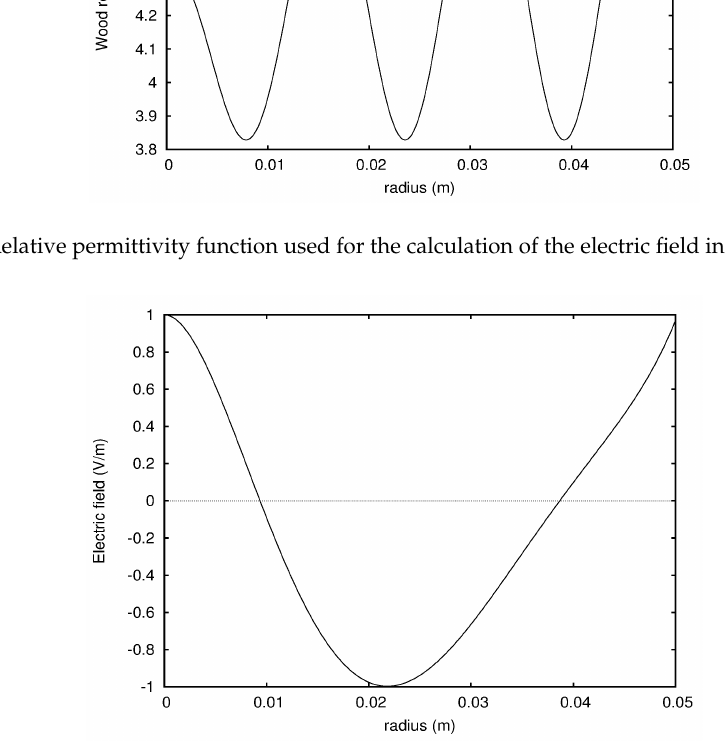
Figure 5. Particular solution with analytical analysis of the electric field inside a cylindrical wood sample when the corrective factor for the effective relative permittivity is 0.70 and the grain angle is α = 45°.